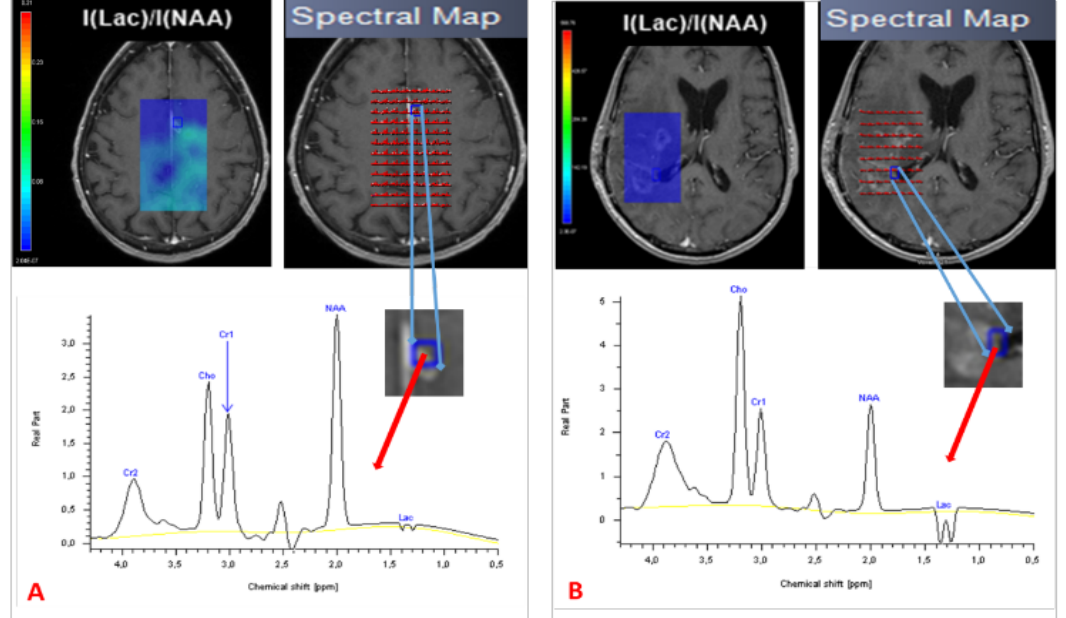
Figure 3. Spectroscopy of two patients treated for GBM, showing PsP with a normal spectrum ( A ) and TP with a high Cho/NAA ratio and Lac peak ( B ). TP = true progression: PsP = pseudoprogression; Cho = choline; NAA = N -acetyl aspartate; Lac = lactate.